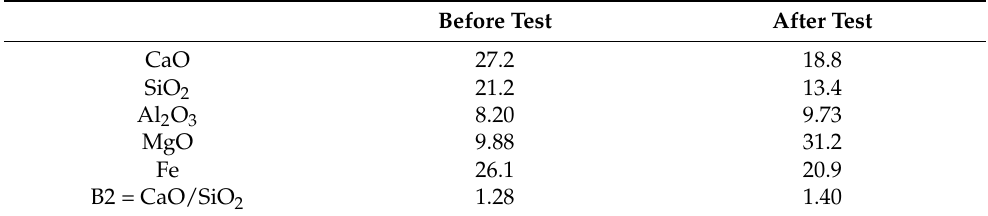
Table 7. EAF-like slag composition in wt.%; all values were measured as elements and converted to oxides. Before